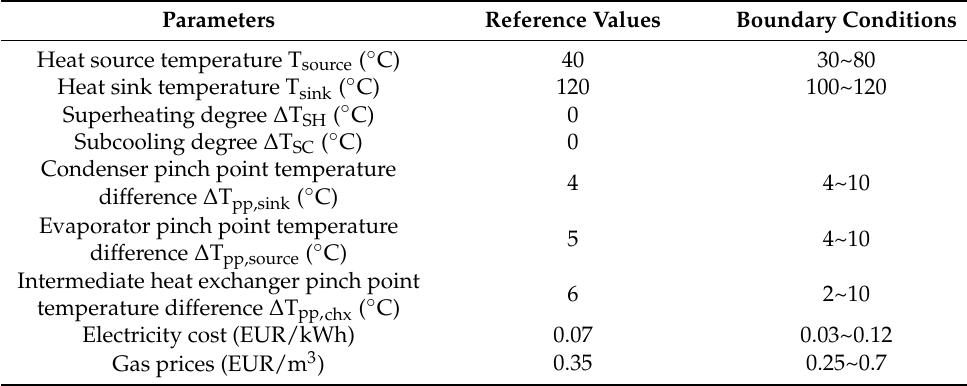
Table 3. The reference values and the boundary conditions.